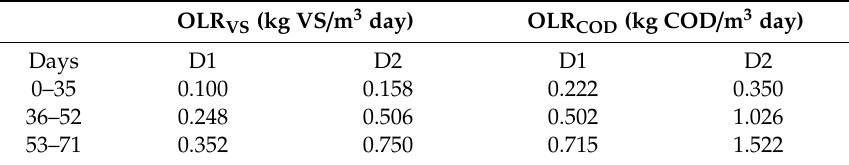
Table 3. Organic loading rates (OLR) in terms of VS and COD maintained in digester D1 and D2 during the experimental